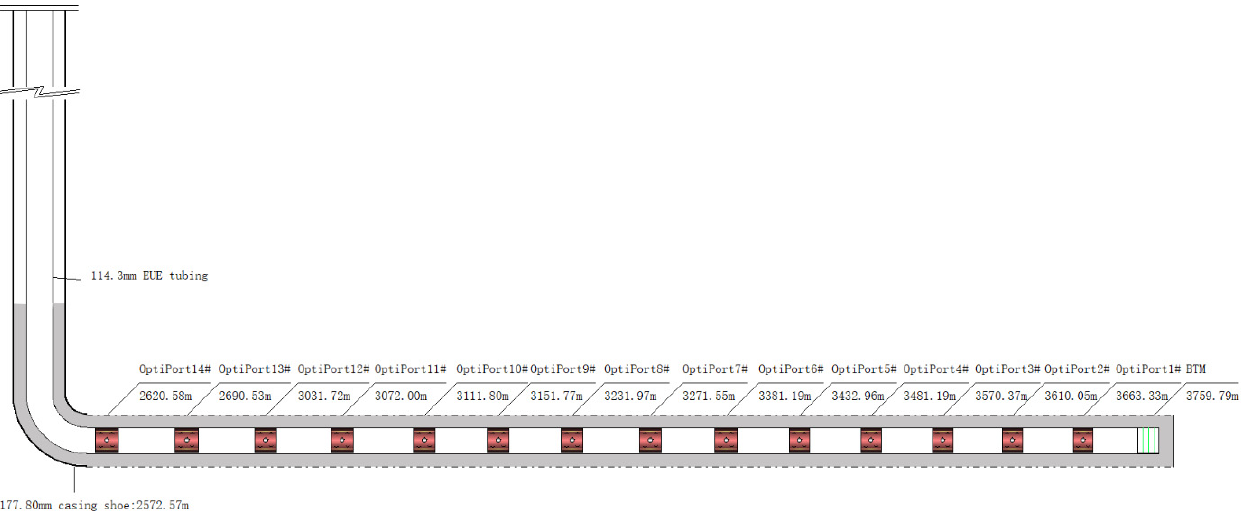
Figure 5. Schematic of infinite sliding sleeve multistage fracturing cementing.